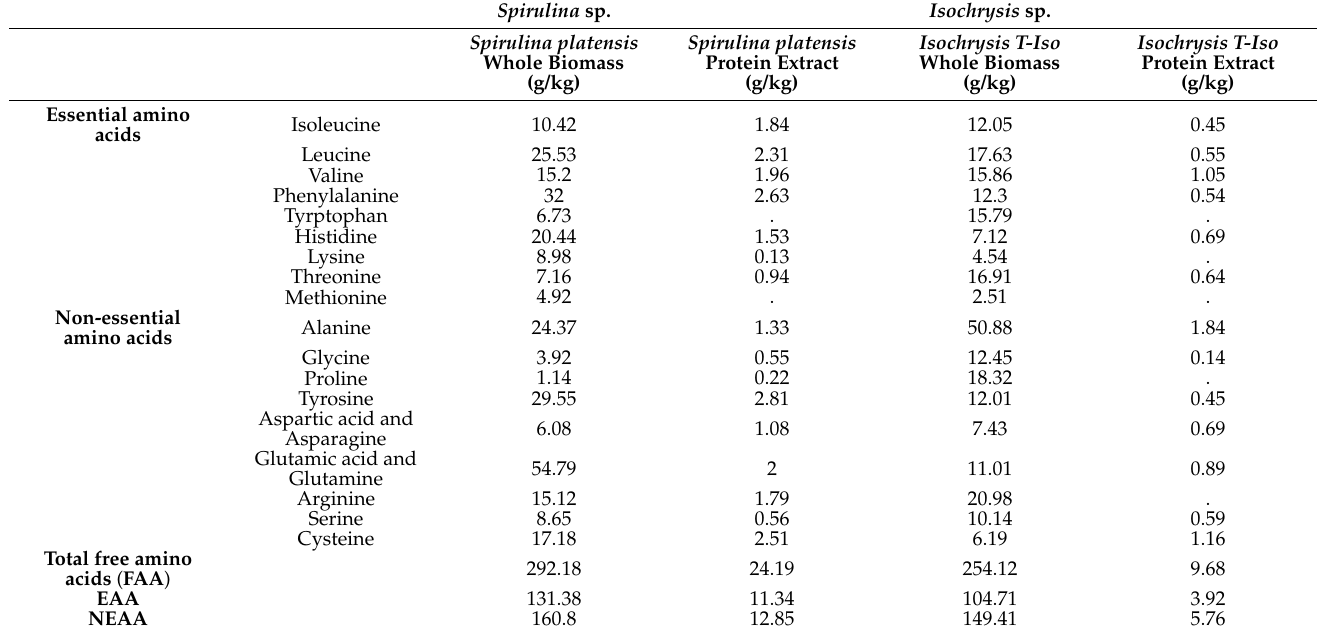
Table 2. Free amino acid contents of the whole alga and protein extracts. Spirulina sp. Isochrysis